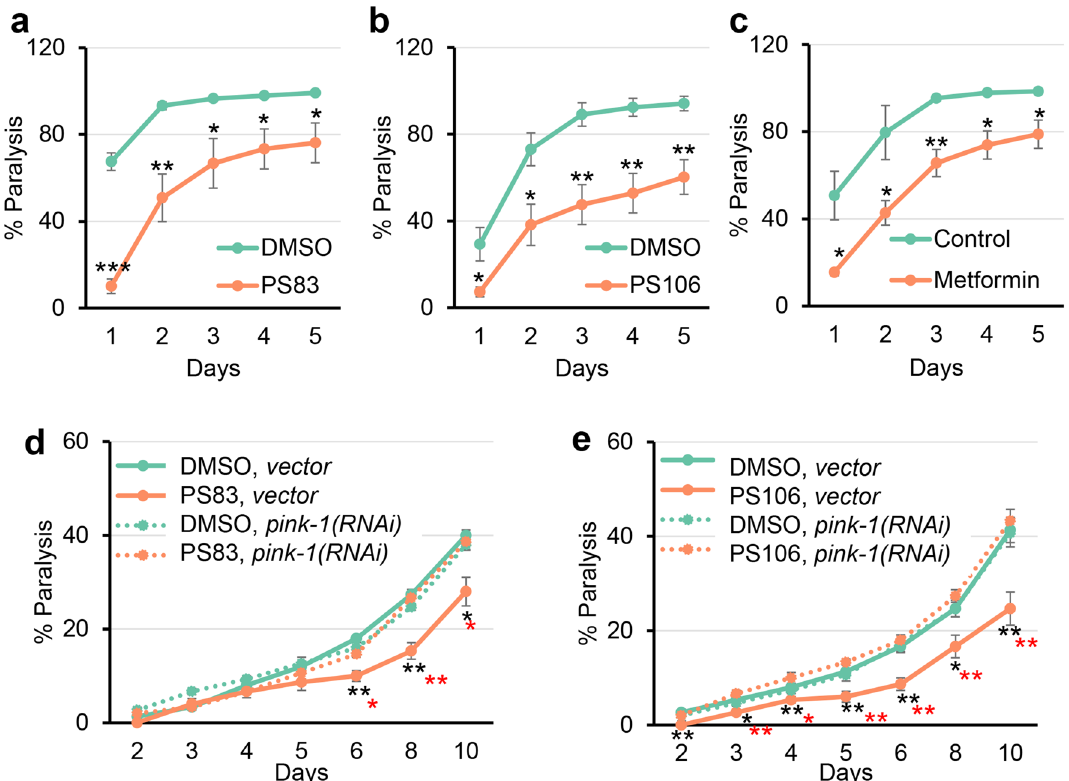
Figure 5. PS83 and PS106 reduced the rate of paralysis in C. elegans strain expressing human beta-amyloid. ( a – e ) Rate of paralysis curve of C. elegans Alzheimer’s model (GMC101) expressing full-length human beta- amyloid upon treatment with ( a , d ) 5 µM PS83, ( b , e ) 25 µM PS106, or ( c ) 100 mM metformin control. In ( d , e ), worms were reared on E. coli expressing cdc-25.1(RNAi)/vector(RNAi) or cdc-25.1(RNAi)/pink-1(RNAi) . At least three biological replicates with ~ 180 worms/replicate were analyzed. p -values were determined from Student’s t -test. * p < 0.05, ** p < 0.01, *** p < 0.001. Black stars indicate significance compared to DMSO control. Red stars in ( d , e ) indicate statistical significance between PS compound on vector versus pink-1(RNAi) -reared